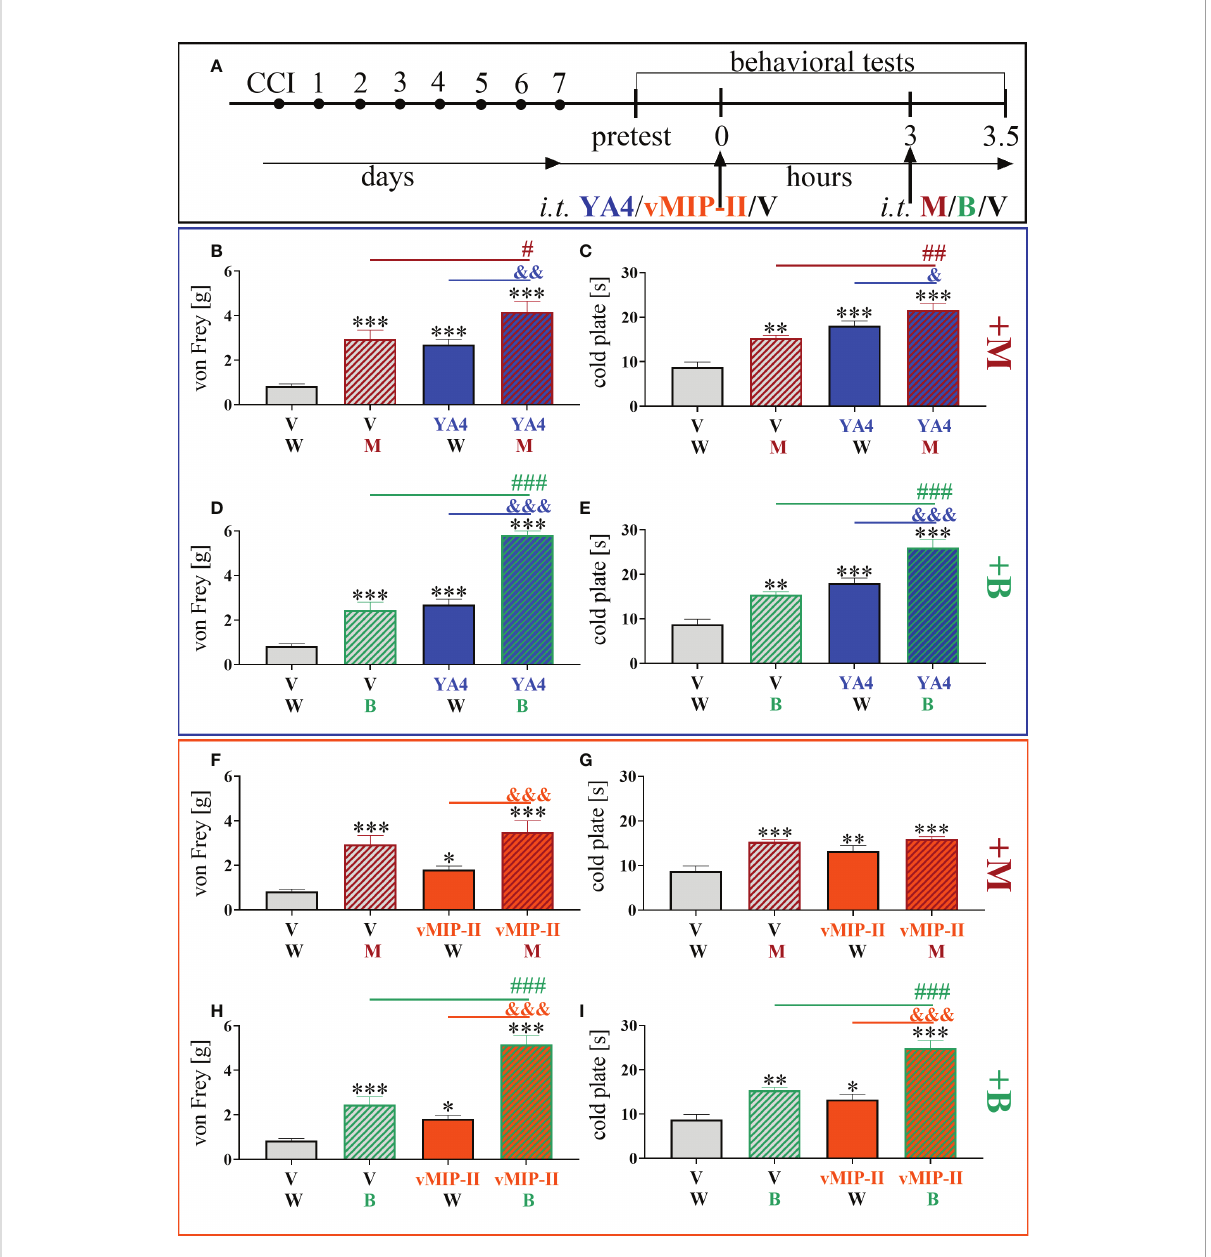
FIGURE 7 The in fl uence of ITGA9 neutralization by YA4 (B – E) or XCR1 blockade by vMIP-II (F – I) at a dose of 1 m g/5 m l on morphine (M) 2.5 m g/5 m l (B, C, F, G) and buprenorphine (B) 2.5 m g/5 m l (D, E, H, I) effectiveness, administered according to scheme (A) , 7 days after chronic constriction injury (CCI) of the sciatic nerve in mice. Data are presented as the mean ± SEM (n =5 – 12). The results were evaluated using one-way ANOVA followed by Bonferroni ’ s post hoc test for comparisons of selected pairs; ✽ p<0.05; ✽✽ p<0.01; ✽✽✽ p<0.001 indicate signi fi cant differences